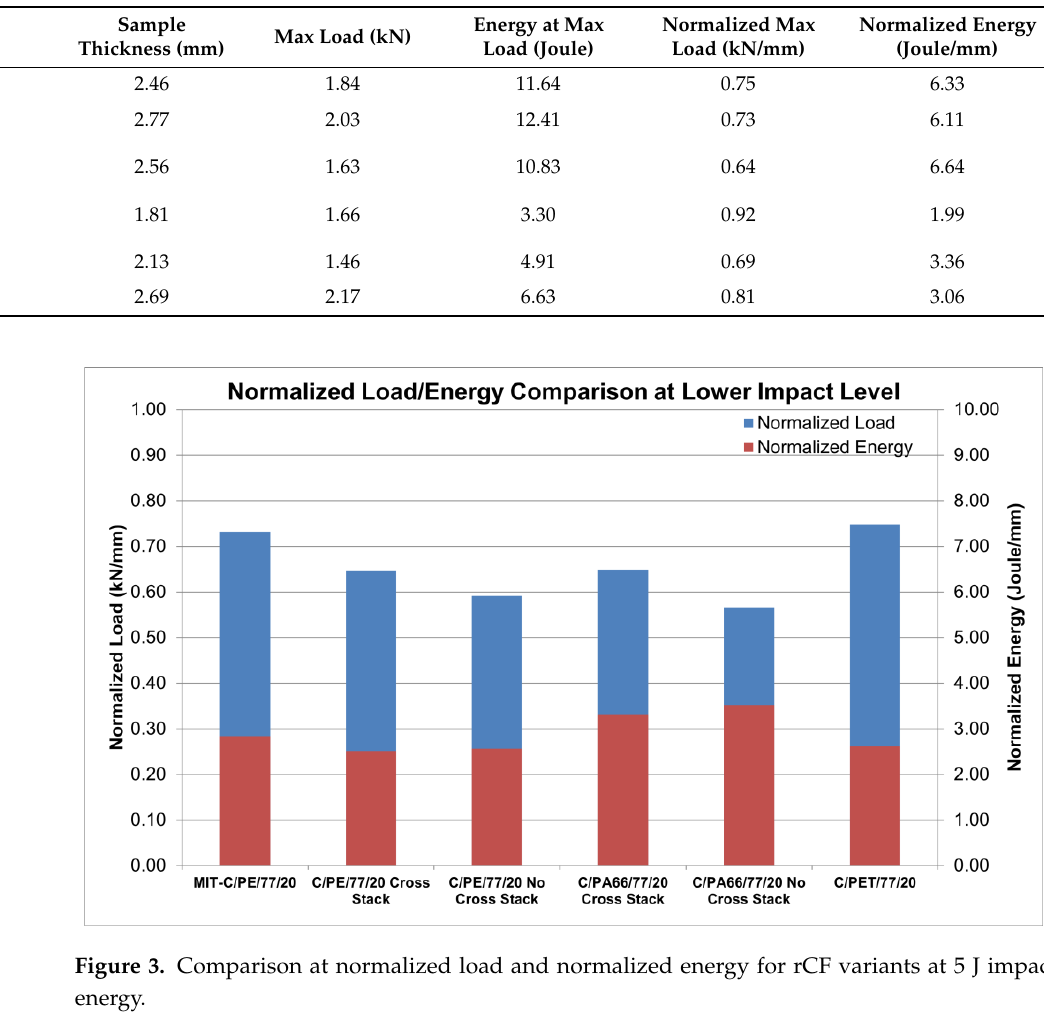
Table 14. Low-velocity impact results at higher impact energy (15 J).